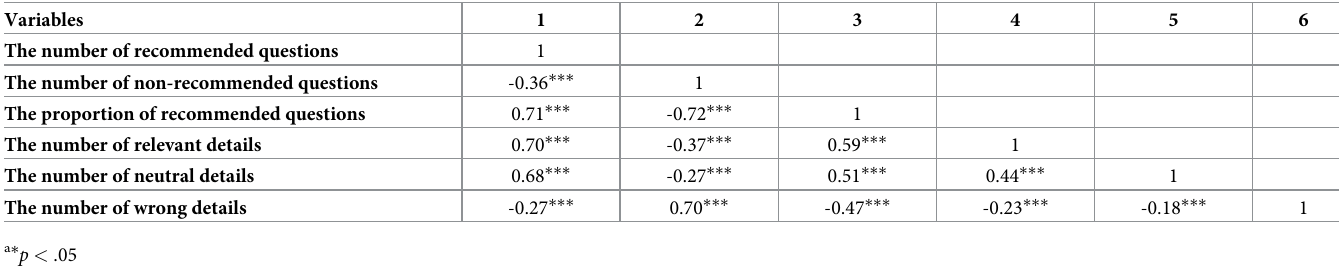
Table 2. a Correlations confirming correct functioning of the